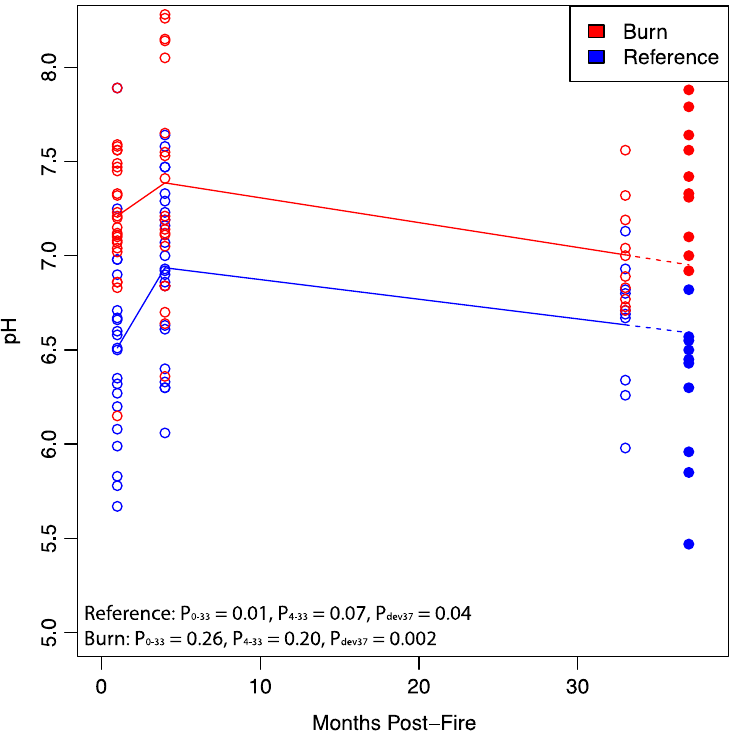
Figure 1. Post-extreme precipitation event burned Soil pH differs from successional trajectory. Quadratic regressions revealed a decrease in reference soil pH from 4 to 33 months post-fire after an initial increase from 0 to 4 months. Burned soils followed a similar trajectory, though pH in burned soils was more variable. Subsequent to the extreme precipitation event, burned soils had higher pH relative to expectations while reference soils experienced a slight decrease in pH.